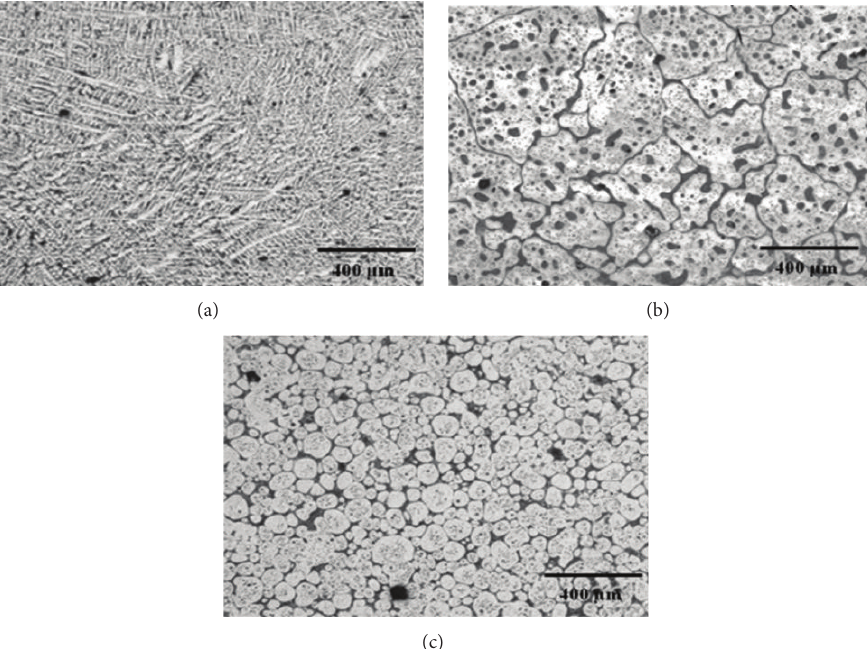
Figure 35: Microstructures of Zn-22Al (a) as-cast, (b) after DPRM at 438 ∘ C for 60min in an as-cast sample, and (c) after solution treatment for 3 hours then subjected to DPRM at 438 ∘ C for 60min